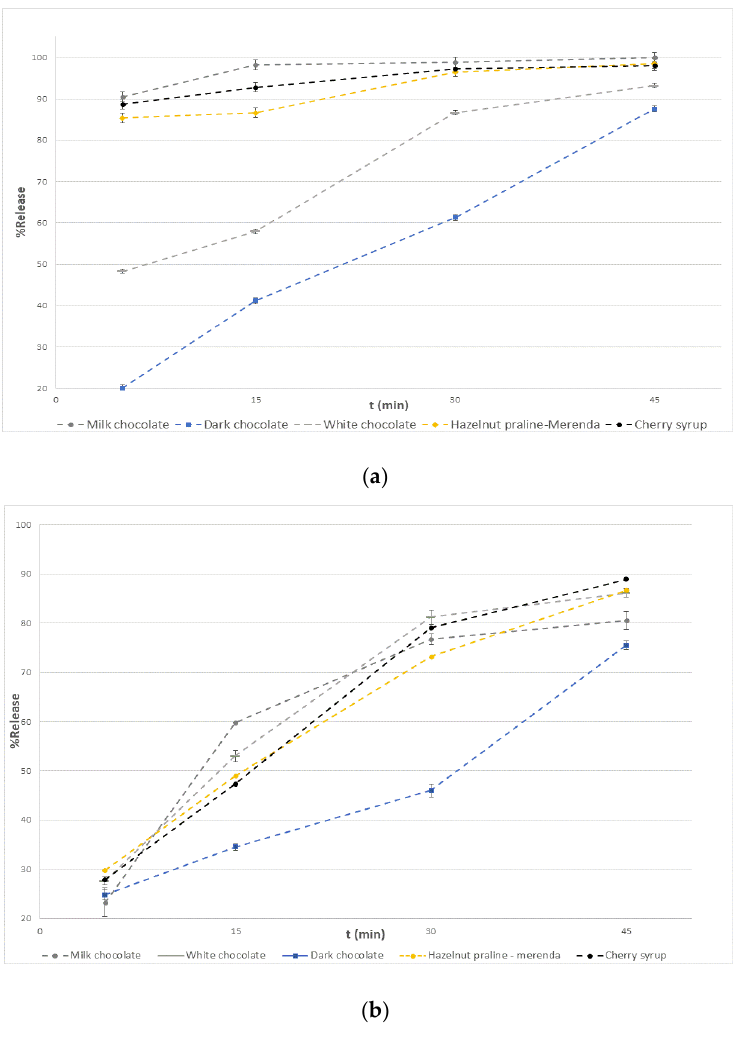
Figure 5. ( a ) Dissolution profiles of all formulations without centrifugation before extraction procedure, ( b ) dissolution profiles of all formulations after centrifugation before extraction procedure.